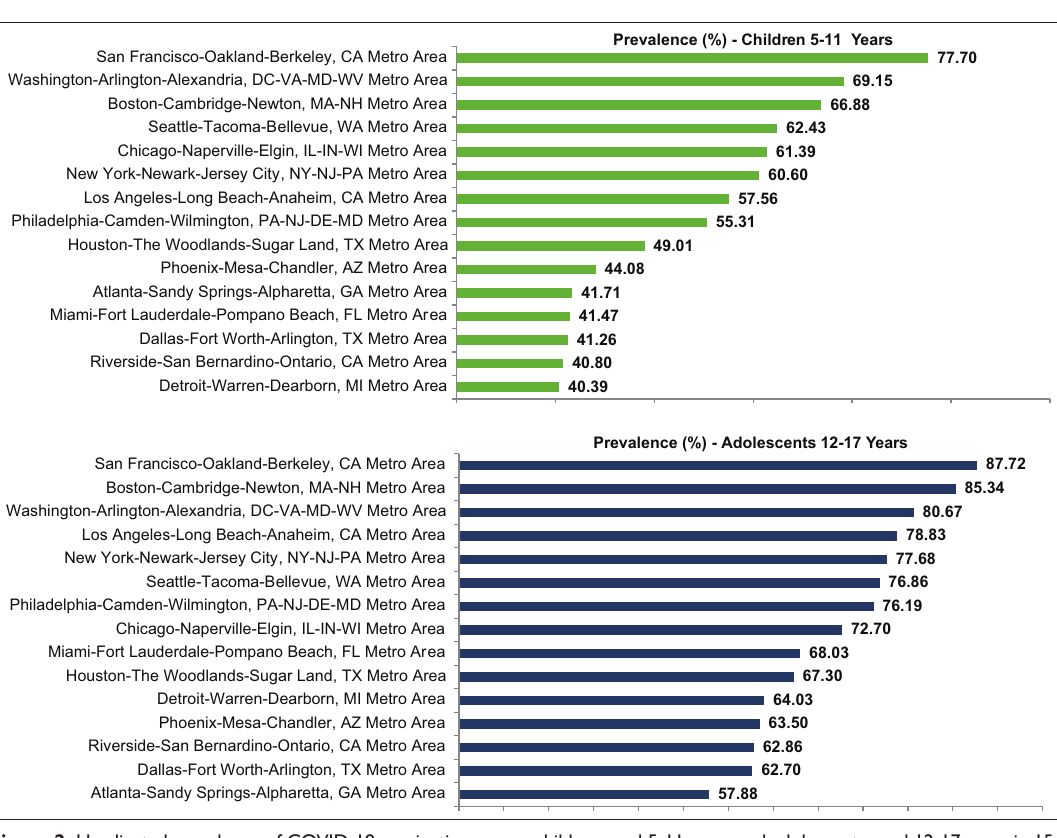
Figure 2: Unadjusted prevalence of COVID-19 vaccination among children aged 5-11 years and adolescents aged 12-17 years in 15 largest Metropolitan Statistical Areas, United States, December 2021 - April 2022. Prevalence rates of COVID-19 vaccination among children aged 5-11 years for all MSAs were significantly lower than the rate for San Francisco-Oakland MSA at p<0.01. Prevalence rates of COVID-19 vaccination among adolescents aged 12-17 years for all MSAs were significantly lower than the rate for San Fran - cisco-Oakland MSA at p<0.05 except for Boston (p=0.41). Source: Data derived from December 2021-April 2022 Household Pulse